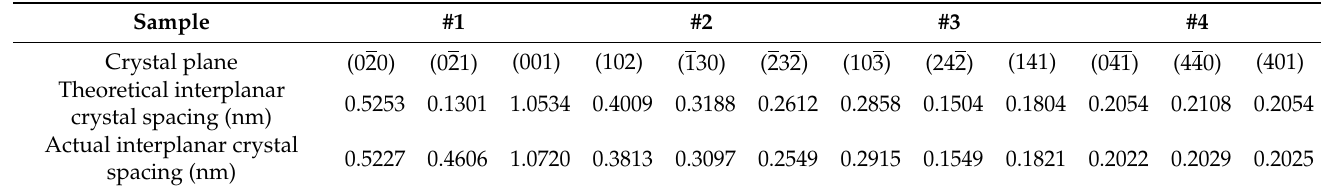
Figure 5. High-resolution TEM images and corresponding diffraction spots of dispersed nanoscale phases in the matrix of FeCrAl ODS steels with different Zr contents (Zr content = ( a 1 , b 1 ) 0 wt.%; ( a 2 , b 2 ) 0.3 wt.%; ( a 3 , b 3 ) 0.6 wt.%; ( a 4 , b 4 ) 1.2 wt.%). (The red circles indicate the boundary of nano-sized particles, and the orange lines indicates the zone axis). Table 3. Interplanar spacing of dispersed nanoscale phases in the matrix of FeCrAl ODS steels.